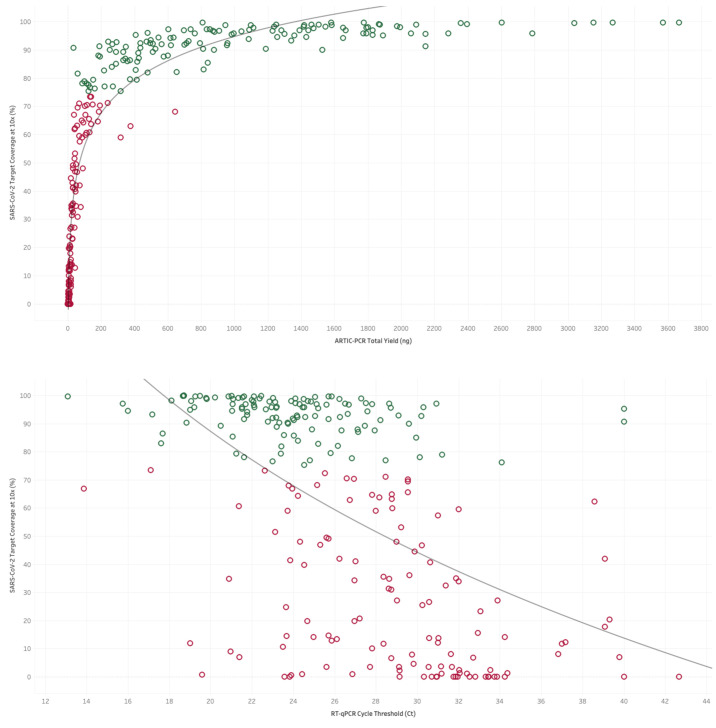
Top. The yield of DNA (ng) from tiled PCR enrichment is a good indicator of the amount of the SARS-CoV-2 genome covered by at least 10 sequencing reads.Green dots represent samples above the 75% threshold set for high-quality sequencing datasets in this study. Bottom. Where available the cycle threshold (CT) value from RT-PCR tests for viral presence is a good indicator of the amount of the SARS-CoV-2 genome covered by at least 10 sequencing reads. Green dots represent samples above the 75% threshold set for high-quality sequencing datasets in this study, demonstrating that most samples which passed this criteria have a CT value less than 31.